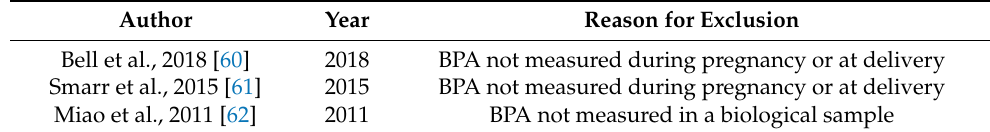
Table 2. Studies excluded from the review.